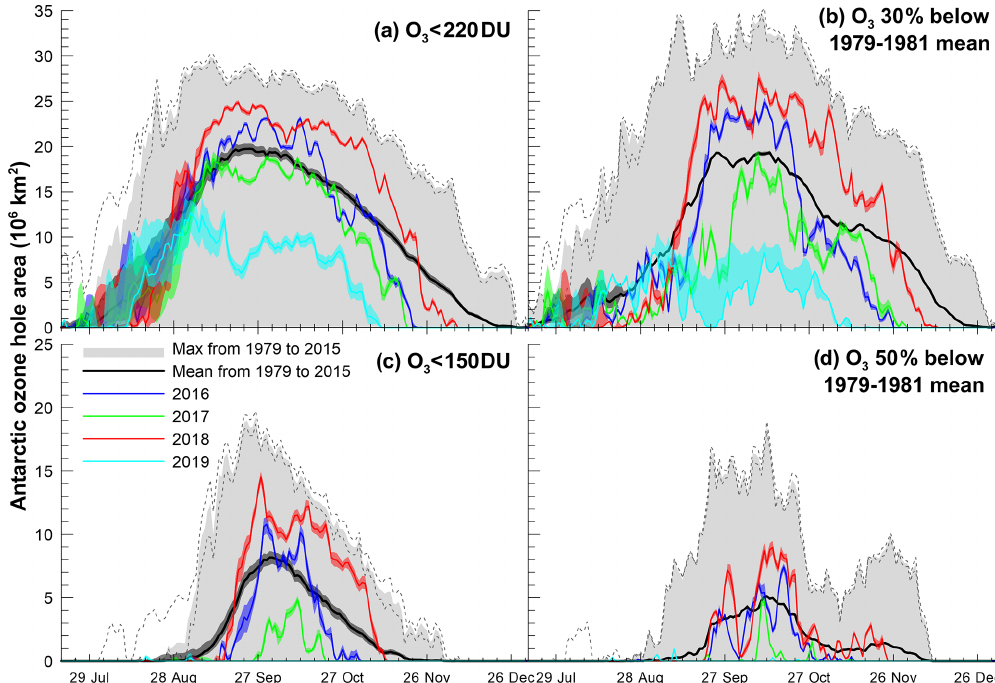
Figure 2. Daily measures of the size of the Antarctic ozone hole using four different criteria. Values for 2016 (blue), 2017 (green), 2018 (red), and 2019 (cyan) are compared against the range of values over the period 1979–2015 (greyed area). Dashed lines show ± 1 σ uncertainties on the 1979–2015 maxima. The mean ozone hole area over the period 1979 to 2015 is shown using a thick black line in all four panels. Coloured shaded regions around each trace indicate ± 1 σ